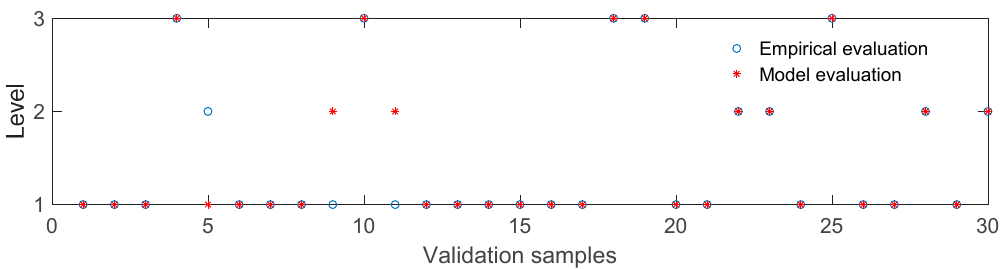
Figure 13. A comparison between the model prediction result and the empirical evaluation result.